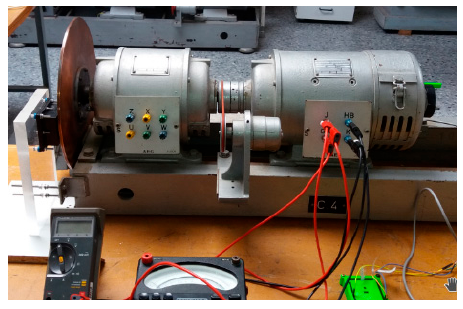
Figure 3. Magnetic brake and DC motor.